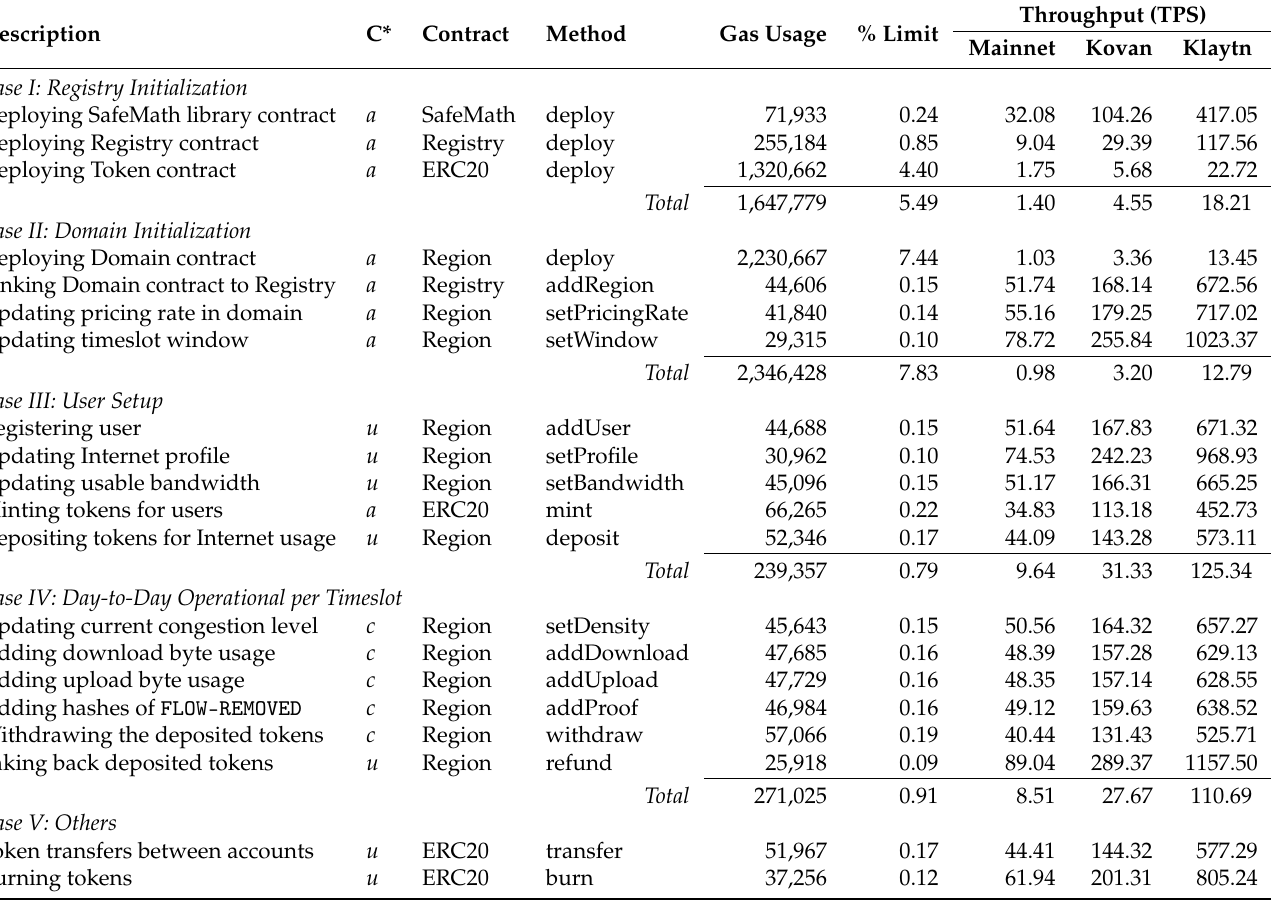
Table 7. List of writable smart contract methods and their gas consumption. We assume the block limit of 30 million gas. The estimated throughput in transactions per second (TPS) is calculated based on the block interval in Mainnet, Kovan, and Klaytn